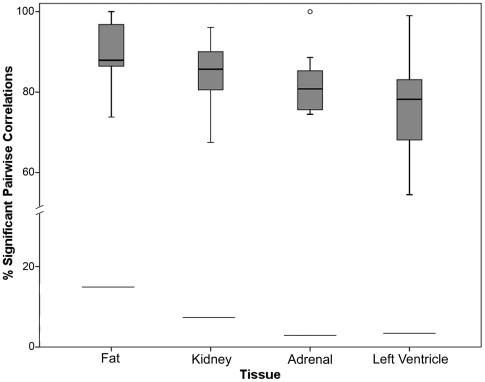
Boxplots showing percentage within-cluster correlation of genes underlying trans-eQTLs forming trans-eQTL clusters.For each of the four tissues, the percentages of significantly correlated pairs of trans-eQTL genes within trans-eQTL clusters are displayed. The boxplots indicate the median, interquartile range, and range of within-cluster correlation in each tissue. The percentage significant correlation among all trans-eQTLs is shown for each of the four tissues as horizontal lines, for purpose of comparison with the trans-eQTL clusters. One outlier is shown, a cluster in adrenal found to have 100% significant pairwise correlation of gene expression levels (see Table S3).